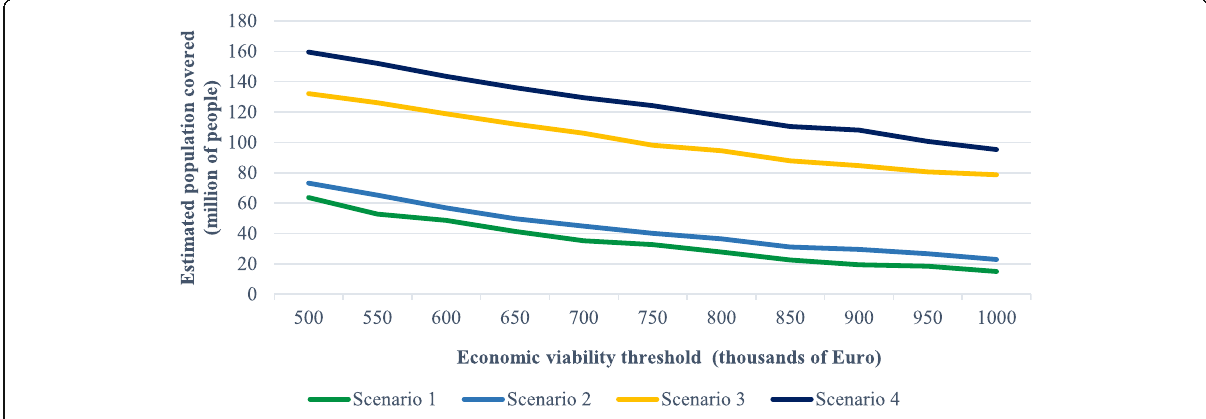
Fig. 8 Number of people having access to service as a function of economic viable threshold of drone-beehives